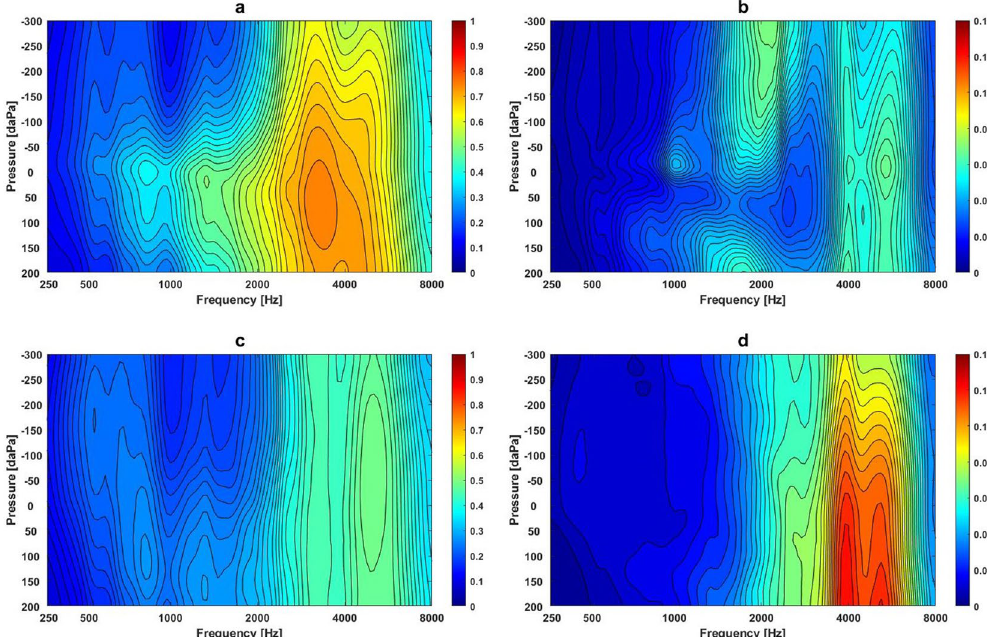
Figure 2. The mean and variance in absorbance at different frequency-pressure regions in the normal middle ear condition and ears with OME: ( a ) Mean absorbance contour plot at different frequencies and pressures in the normal middle ear condition; ( b ) Variance of absorbance contour plot at different frequencies and pressures in the normal middle ear condition; ( c ) Mean of absorbance contour plot at different frequencies and pressures in ears with OME; ( d ) Variance of absorbance contour plot at different frequencies and pressures in ears with